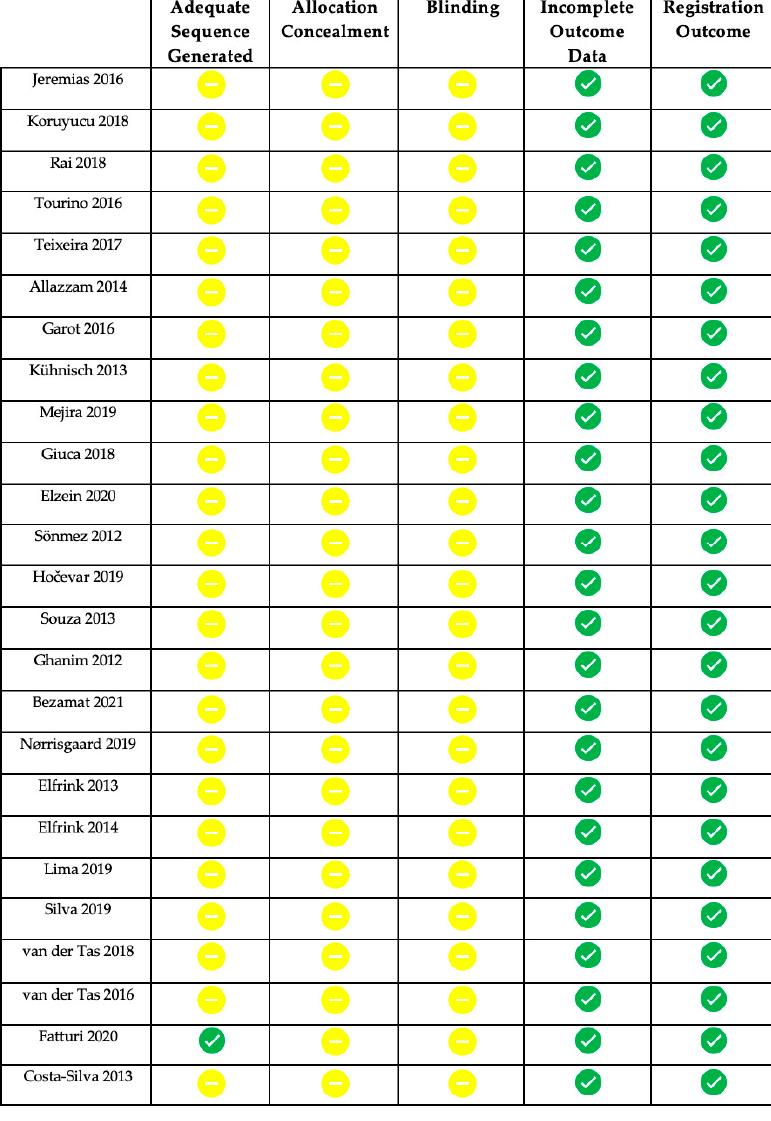
Figure 2. Green symbol: low risk of bias; yellow symbol: moderate risk of bias (also used for lack of information).